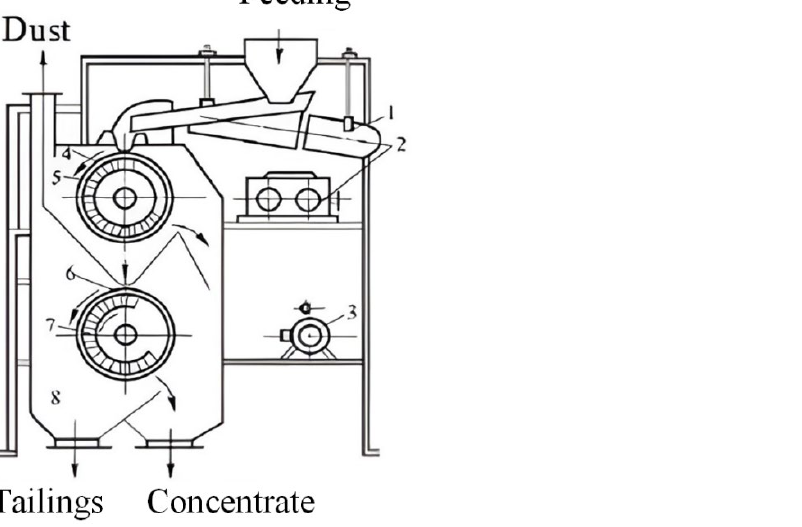
Figure 3. Structure diagram of CTG permanent magnet double-barrel dry magnetic separator: 1—electric vibration feeder; 2—stepless governor; 3—electric motor; 4—upper roller; 5, 7—circular magnetic deficiency system; 6—lower roller; 8—box [23].